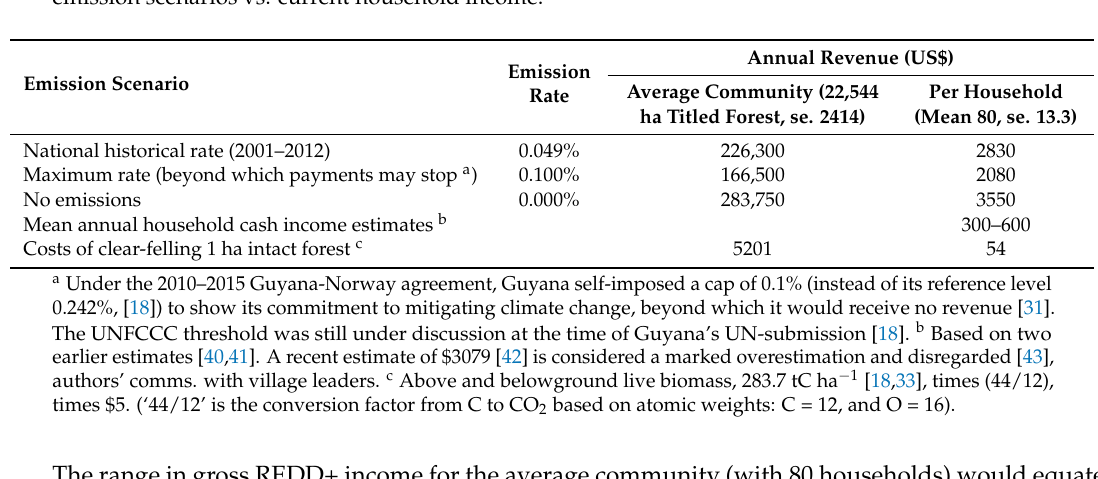
Table 1. Gross annual Reducing Emissions from Deforestation and forest Degradation (REDD+) revenue for the average indigenous community ( n = 15) and household equivalent under different emission scenarios vs. current household